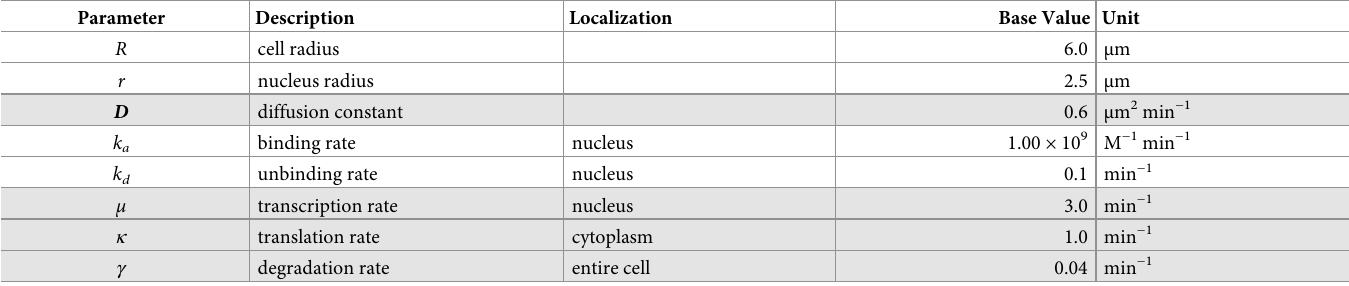
Table 1. Base parameters as presented in [32]. The parameters to be estimated with Bayesian inference are highlighted in grey and are varied over several orders of mag- nitude in the synthetic data sets. Parameters μ , κ and γ are varied simultaneously by multiplying them by a common variable, noted χ . This variable and the diffusion con- stant are the targets to be